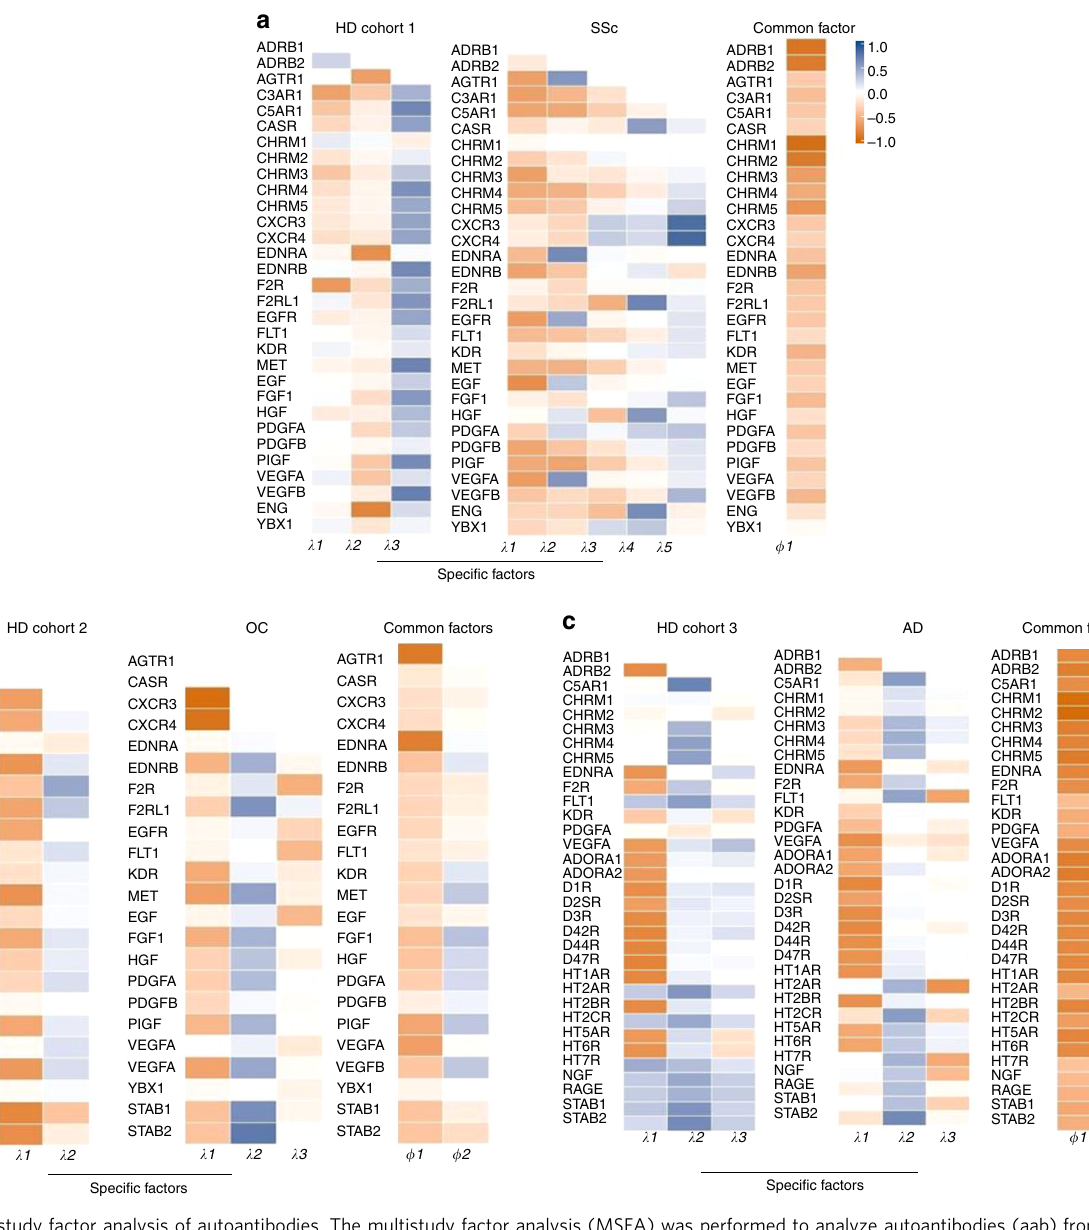
Fig. 7 Multistudy factor analysis of autoantibodies. The multistudy factor analysis (MSFA) was performed to analyze autoantibodies (aab) from healthy donors (HD) compared with patients with a systemic sclerosis (SSc), b ovarian cancer (OC), and c Alzheimer ’ s disease (AD). Supplementary Tables 1 and 2 provide further details about the HD and patient groups, as well as the aab datasets analyzed. The images are heatmaps of estimated factor loadings of common and speci fi c latent factors. The color scale bar ranging from orange ( − 1 to 1) to blue corresponds to negative and positive factor loadings. Loadings close to − 1 or 1 indicate aab that strongly in fl uence factors in opposite directions production 3 . In addition, we reverse-engineered the functions of aab through the in discriminate the global aab signature of HD and patient groups 59 as appropriately recommended to analyze immunological data 60 . MSFA (described in detail below), silico evaluation of aab (aab dataset 1) target interactions using STRING 64 and GO using a fast expectation conditional-maximization algorithm for the parameter analysis according to the Gene Ontology Consortium 65 to gain insight into the physiological roles 66 of aab. Enrichment analysis of the GO biological processes estimate 28 , was used to comprehend the correlation structure of the aab network. This approach is a generalized version of factor analysis that is able to handle was considered signi fi cant when the false discovery rate/adjusted p value was ≤ 0.05. multiple studies simultaneously to identify common and study-speci fi c factors shared by different studies 28 . MSFA considers all data at once in an integrated approach, estimating parameters by maximum-likelihood analysis 61 . MSFA IL-8 release . HD-IgG (0.5mg/ml) was used as a standard in all experiments as allowed the identi fi cation of speci fi c and shared factors among aab from three previously described 32 . In summary, after Fc- γ receptor blockade, 1 ×10 6 PBMCs different cohorts of HD (Supplementary Table 1) analyzed for three aab datasets isolated from heparinized blood as previously described 31,67 were activated by a (Supplementary Table 2) and in comparison to cohorts of patients with SSc, AD, pool of heterologous puri fi ed IgG from 10 different HD. After 20 h of culture in the and OC, respectively. Hierarchical clustering of Pearson's correlations of aab 62 was absence or presence of the 100 µM EDNRA antagonist sitaxsentan (P fi zer Inc., carried out using the Perseus software 63 (MaxQuant, v1.11, Martinsried, Germany) New York, NY, USA), the supernatants were harvested and evaluated for the to assess the correlation signatures of aab. When indicated, HD were subdivided presence of IL-8 using ELISA according to the manufacturer ’ s instructions (R&D according to gender and age (< and ≥ 65 years of age), with the latter representing Systems, Minneapolis, MN, USA). the life period most associated with increased dysregulation of natural antibody NATURE COMMUNICATIONS| (2018) 9:5224 |DOI: